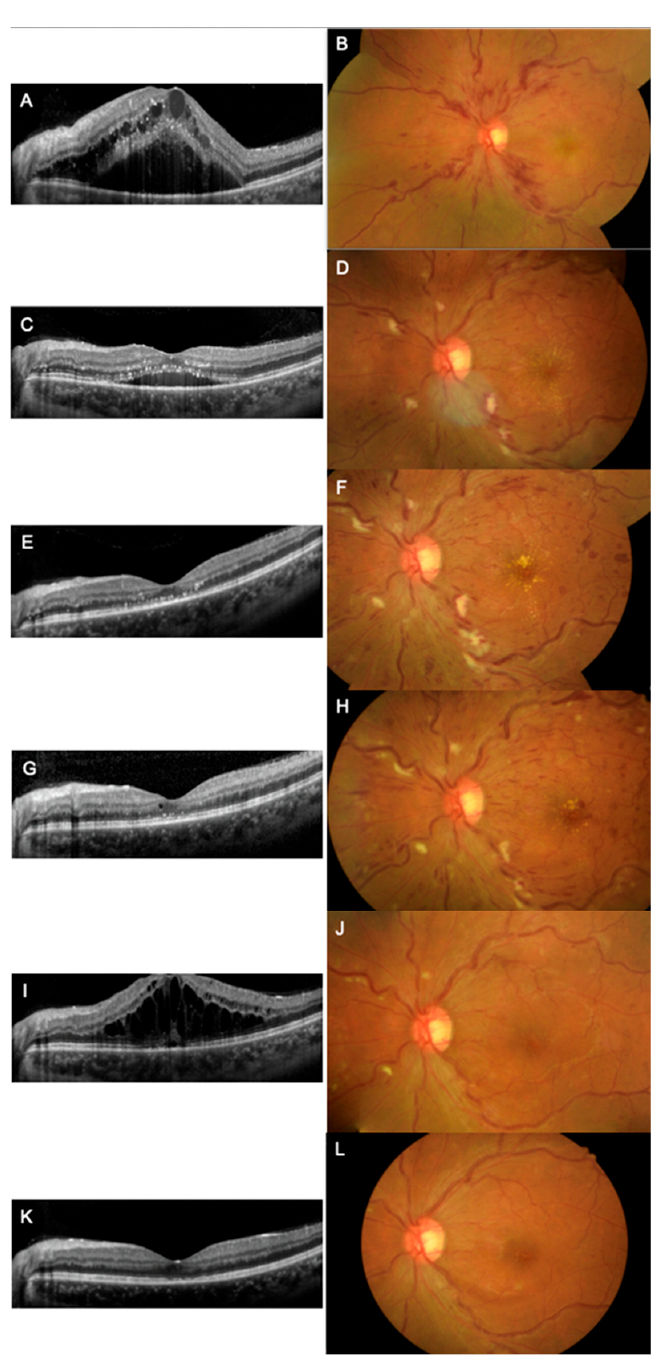
Figure 1. SD-OCT and color fundus imaging over the 7 months since first presentation. ( A , B ) Initial presentation of diffuse flame shape hemorrhage, macular edema and disc edema with visual acuity of 20/100 in the left eye. ( C , D ) Three weeks after intravitreal injection of ranibizumab, macular edema decreased. Intravitreal injection of aflibercept was given for incomplete treatment response to ranibizumab. ( E , F ) Six weeks after the diagnosis, macular edema subsided. ( G , H ) Three months after the diagnosis, progressive retinal hemorrhage was observed. A second dose of aflibercept was given. ( I , J ) Six months after the initial diagnosis, recurrent macular edema was observed and the third dose of aflibercept was administered. ( K , L ) Seven months after the diagnosis, macular edema completely subsided with no retinal hemorrhage observed.